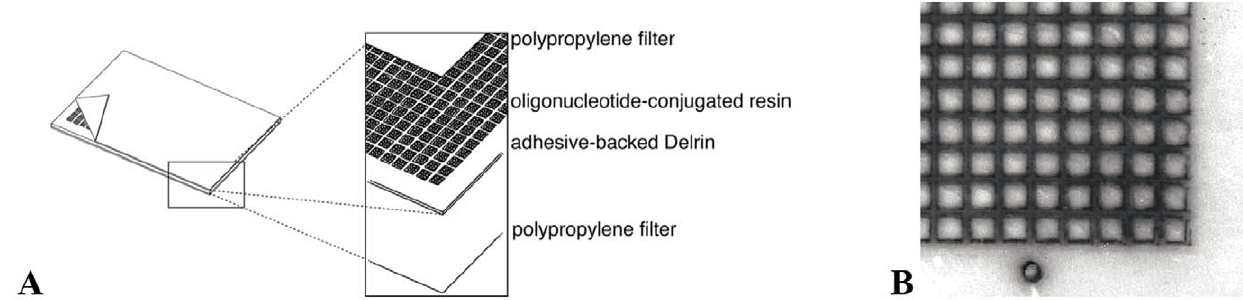
Figure 5. Construction of an anticodon array. (A) Oblique and exploded views of an anticodon array. The arrays are constructed by sealing one side of an adhesive-backed, lasercut Delrin sheet with a polypropylene filter, filling the resulting wells with oligonucleotide-conjugated resin, and then sealing the opposite side of the array with a second polypropylene filter. (B) Photograph of the lower right corner of an anticodon array.